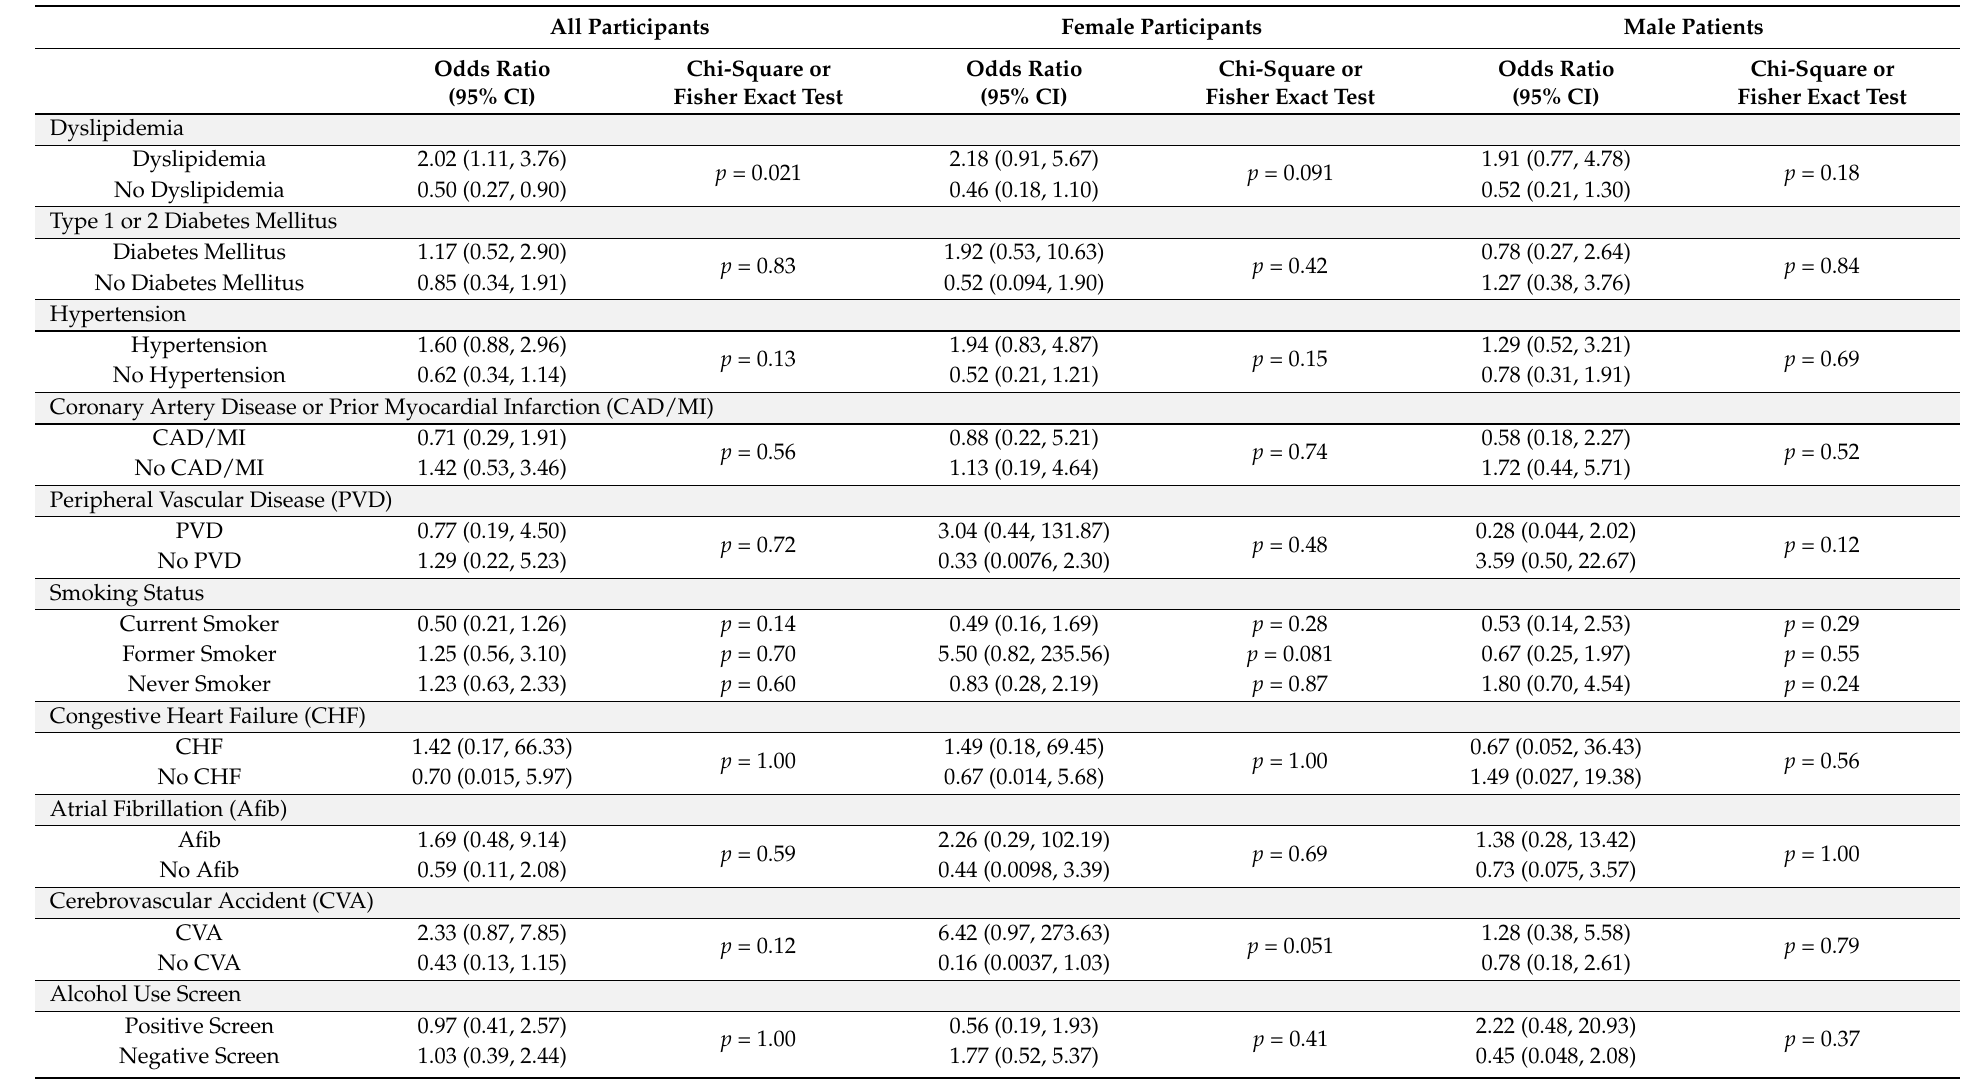
Table 6. Crude odds of vaccination by medical comorbidity for all patients with neurological disorders and stratified by